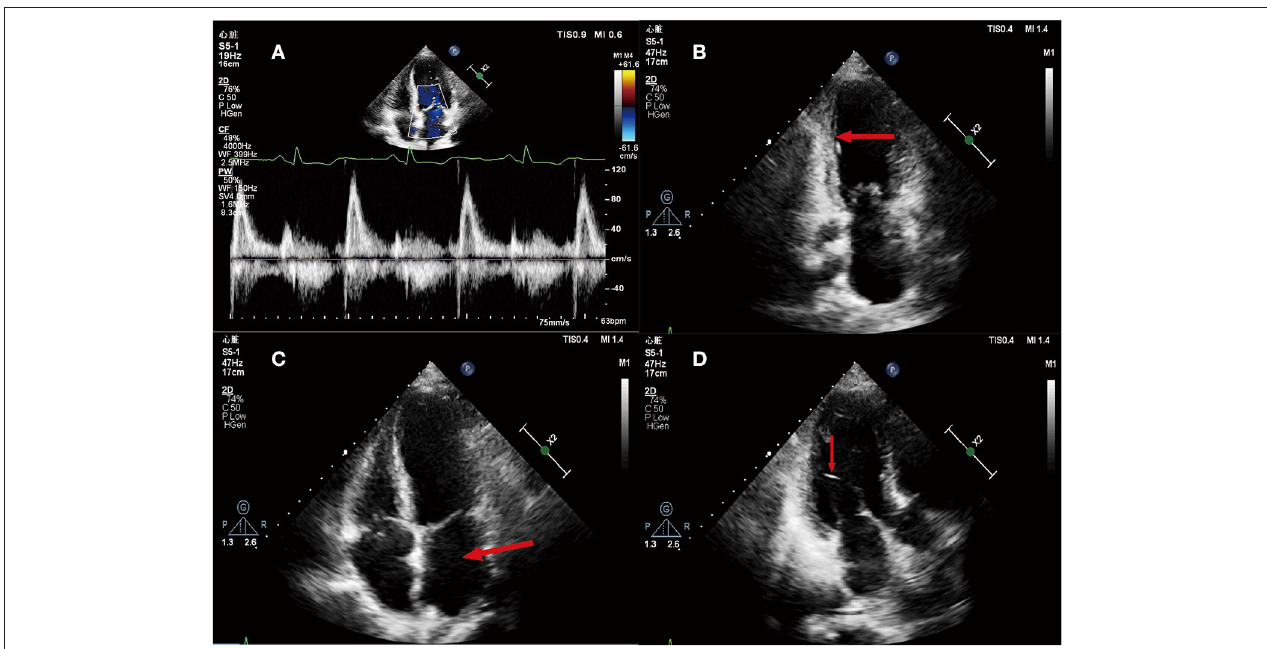
FIGURE 2 | (A) Mitral flow spectrum Doppler; (B) Apical two-chamber heart view, Ventricular systole. The arrow shows that the inferior wall of left ventricle became thinner, the echo increased, and the mobility decreased; (C) Apical four-chamber heart view. The arrow indicates the enlargement of left atrial; (D) Apical two-chamber heart view, Ventricular systole. The arrow shows a left ventricular false tendon.